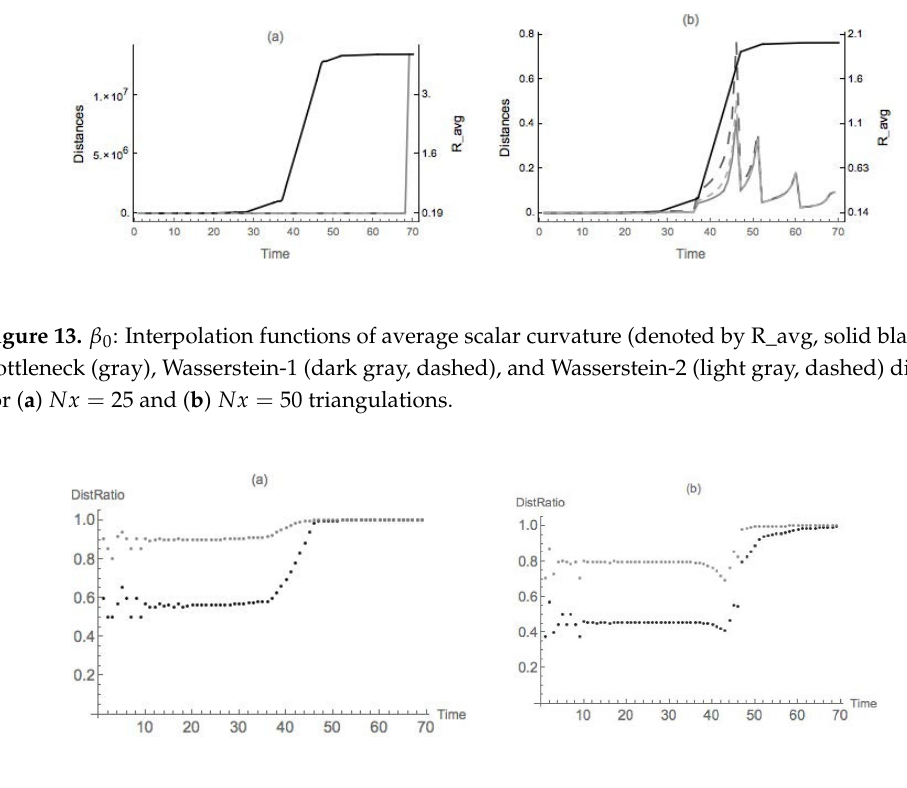
Figure 14. β 0 : Interpolation functions of ratios of bottleneck distance to Wasserstein-1 distance (black dots) and Wasserstein-2 distance (gray dots) for ( a ) Nx = 25 and ( b ) Nx = 50